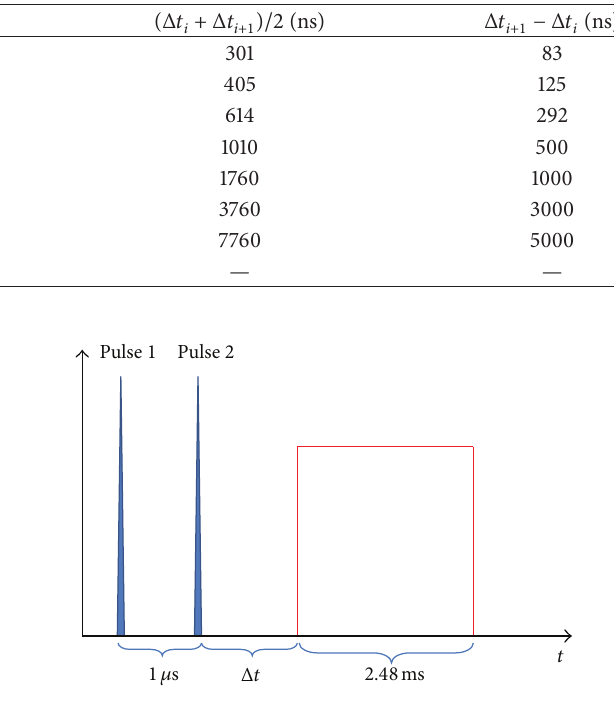
Figure 2: Scheme of the acquisition delay and gate.